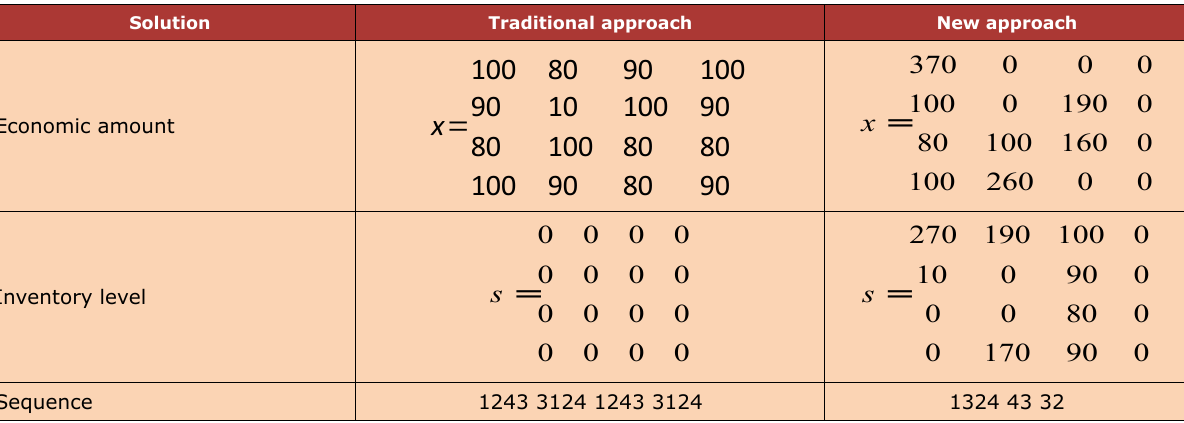
Table 2. Comparing Economic amounts, Inventory levels and Sequences